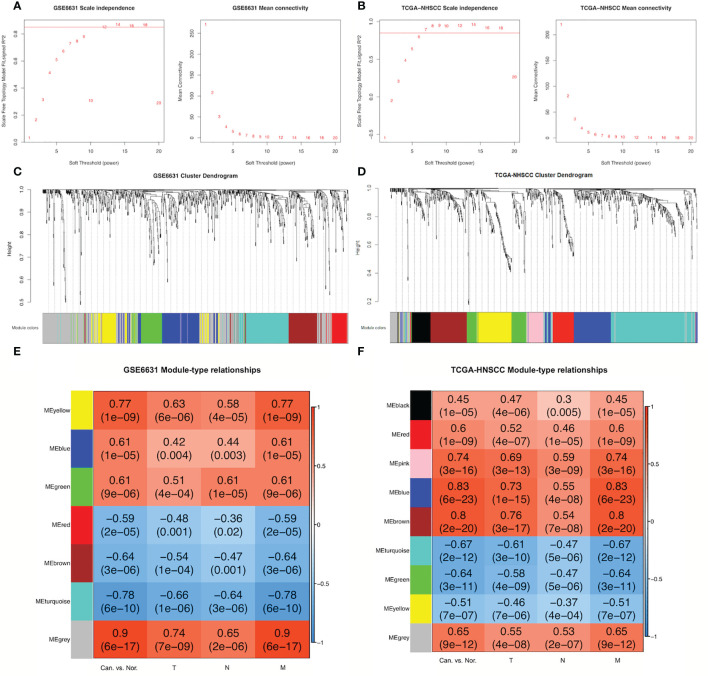
Construction of GSE6631- and TCGA-HNSCC-specific modules using WGCNA. (A) Network topology for different soft-thresholding powers of GSE6631. Left: the scale-free topology fit index (y-axis) in the GSE6631 dataset; right: the mean connectivity (y-axis) as a function of the soft-thresholding power (x-axis) in the GSE6631 dataset. (B) Network topology for different soft-thresholding powers of TCGA-HNSCC. Left: the scale-free topology fit index (y-axis) in the TCGA-HNSCC dataset; right: the mean connectivity (y-axis) as a function of the soft-thresholding power (x-axis) in the TCGA-HNSCC dataset. (C) Branches of the clustering dendrogram from different modules based on differentially expressed genes (DEGs) in GSE6631. Based on the unsupervised hierarchical clustering, GSE6631 DEGs were clustered into seven modules (yellow, blue, green, red, brown, turquoise, and gray). (D) Branches of the clustering dendrogram from different modules based on DEGs in TCGA-HNSCC. Based on the unsupervised hierarchical clustering, TCGA-HNSCC DEGs were clustered into nine modules (black, red, pink, blue, brown, turquoise, green, yellow, and gray). (E) Module-clinical feature relationships in the GSE6631 modules. In the heatmap, red represents a positive correlation, whereas blue represents a negative correlation. The numbers in each block are the related-value and P-value of the correlation. (F) Module-clinical feature relationships in TCGA-HNSCC modules. In the heatmap, red represents a positive correlation, and blue represents a negative correlation. The numbers in each block are the related-value and P-value of the correlation.